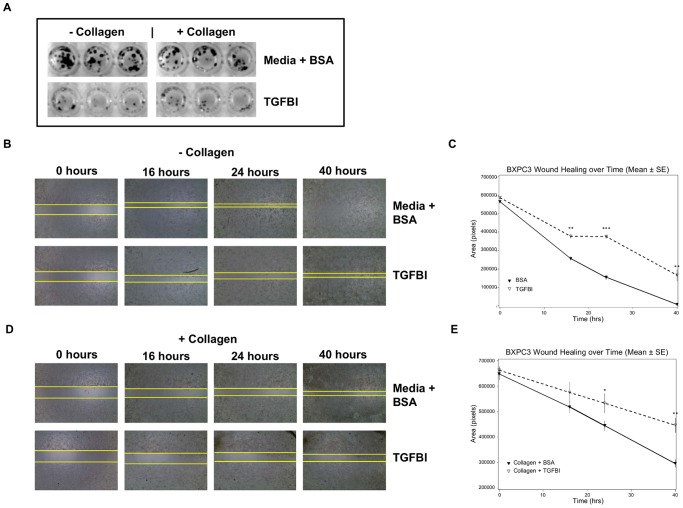
TGFBI modulates growth and migration of BXPC3 cells.(a) Exogenous addition of TGFBI completely eliminated BXPC3 colonies as determined by crystal violet staining. (b) and (d) Wound healing capacity of BXPC3 cells was reduced by TGFBI in the absence and presence of collagen. The area of wound closure was photographed at different time points over a period of 40 hours. (c) and (e) The rate of wound healing over time is presented here for both conditions. The area closure was measured using the Image J program. TGFBI treatment showed an overall 50% inhibition of wound healing (***, p<0.0001). In all cases media supplemented with BSA was used as a negative control. BSA (▾), TGFBI (▽).